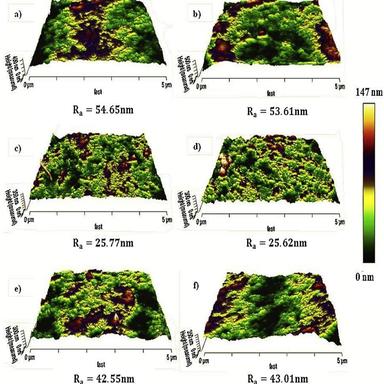
3D AFM outer surface images of membrane with zero (left) and 8-cm (right) air gap, (a,b) PVDF membrane, (c,d) PVDF/PLA-1 membrane and (e,f) PVDF/ PLA-3 membrane.